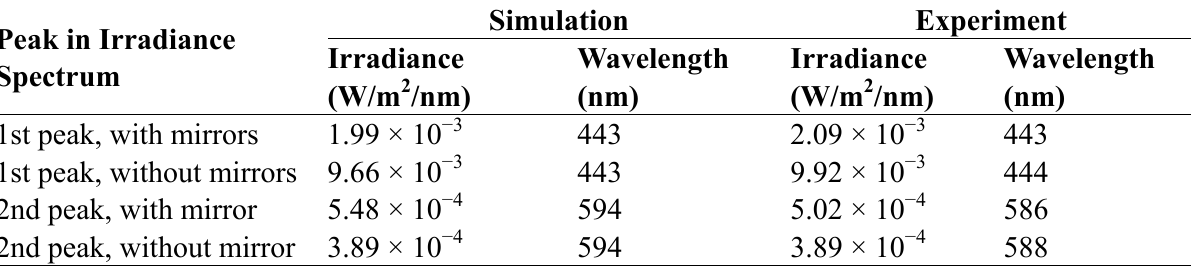
Table 2. Peak irradiance and wavelength in irradiance spectrum.